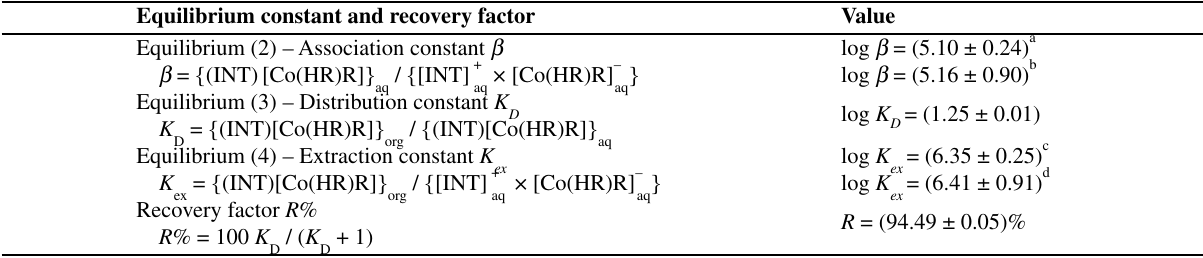
Table 2. Values of the equilibrium constants and the recovery factor Equilibrium constant and recovery factor